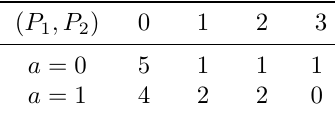
Table 2: Histogram of the joint distribution of ( P 1 , P 2 ) for a = 0 and a = 1. ( P 1 , P 2